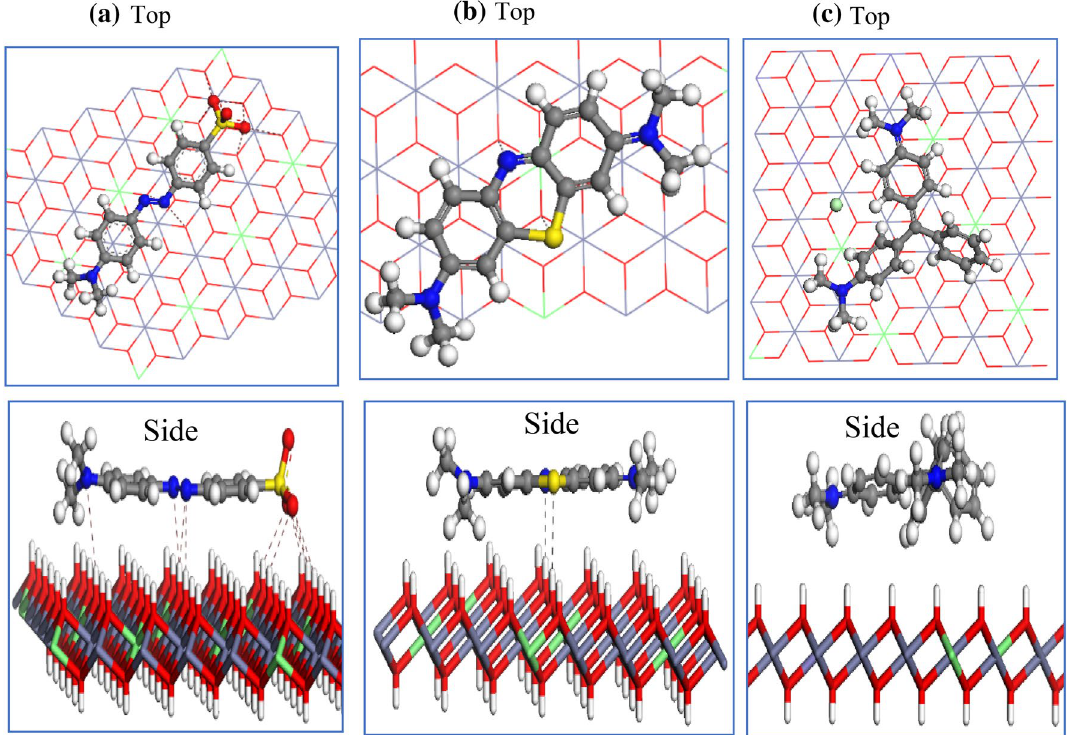
Figure 16. The adsorption of MO ( a ), MB ( b ), and MG ( c ) molecules on the Zn–Fe LDH (001) surface, as obtained from the MC